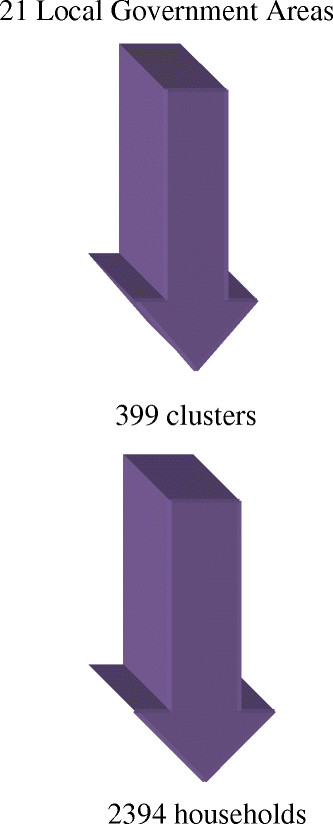
Flowchart showing sample selection process from local government areas to households.